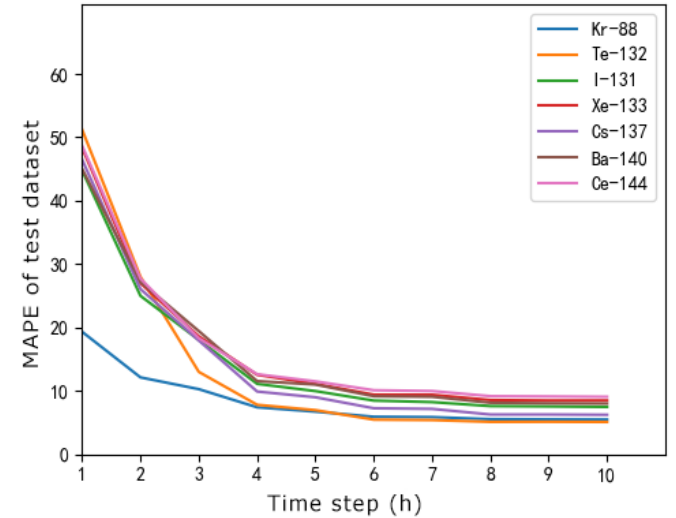
Figure 11. Prediction results of fusion model with time step. Table 7. The MAPE of seven nuclides predicted by each model at the final time step.